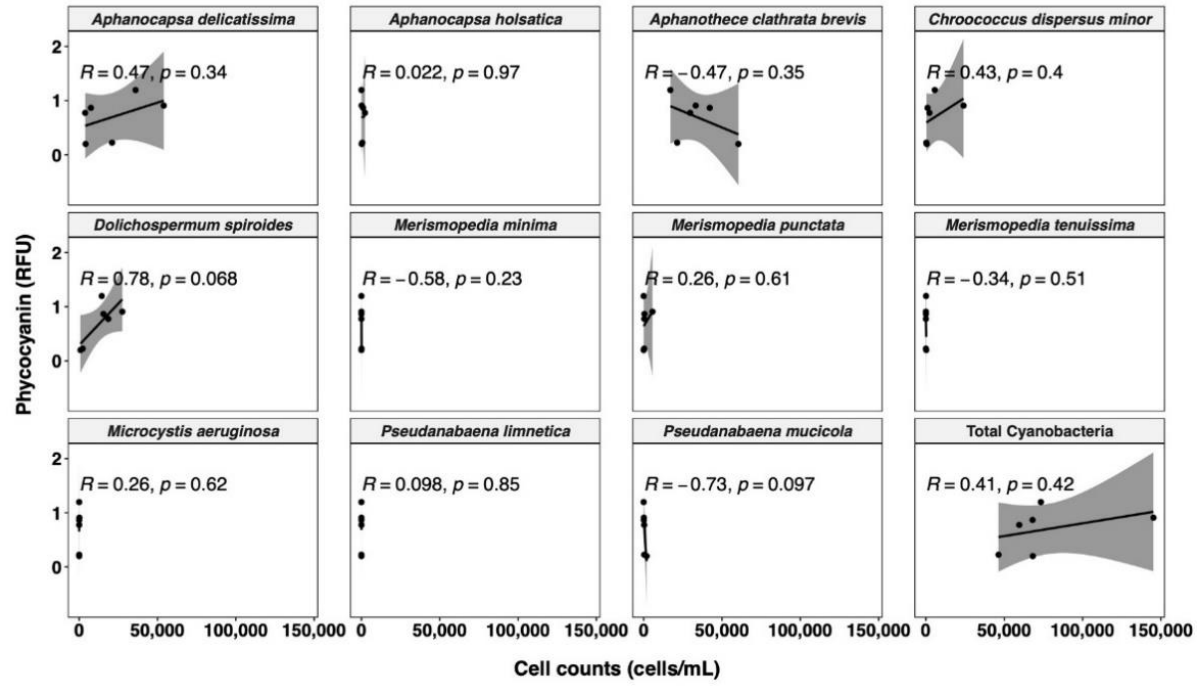
Figure 6. Relationship between phycocyanin probe readings and cell counts for different cyanobacterial species. Shaded area around the line represents the 95% confidence interval.